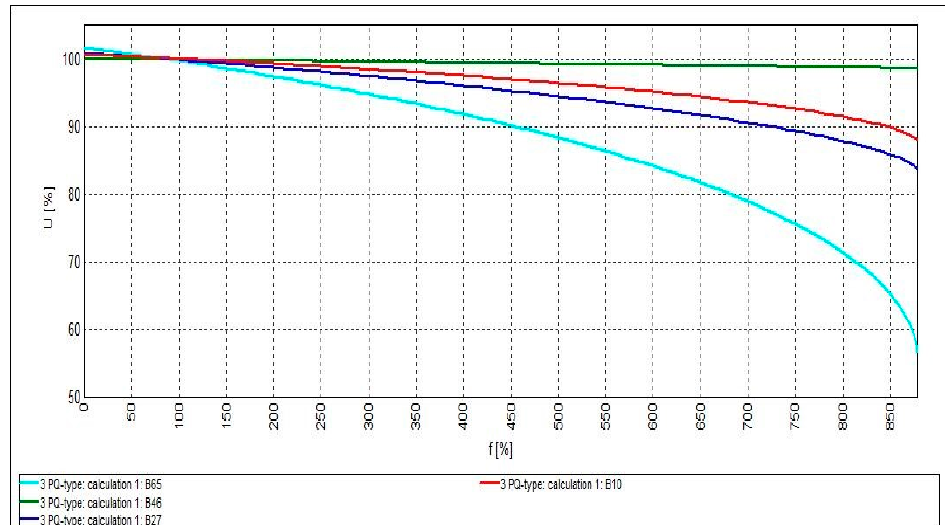
Figure 12. PV curves of the IEEE 69 ‐ node RDS system with 3 PQ ‐ type DG installations.